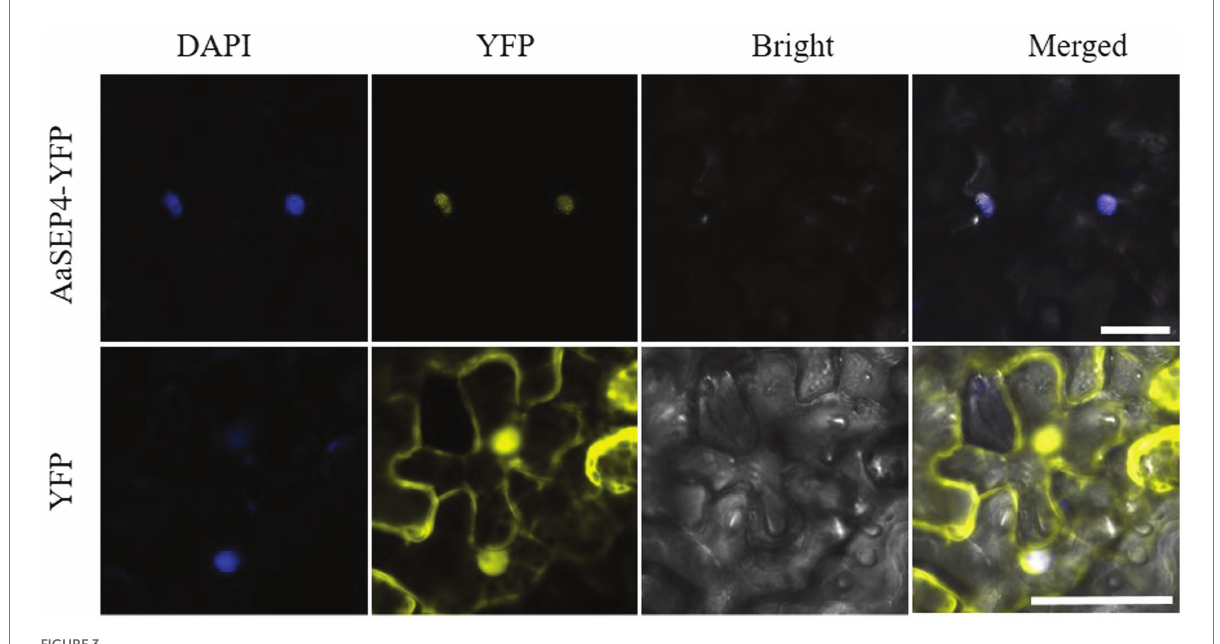
FIGURE 3 The subcellular localization of AaSEP4 in leaves of N. benthamiana. Yellow, yellow fluorescent protein (YFP). Blue, 4 ′ , 6-diamidino-2-phenylindole staining (DAPI). Bars, 50 μ m.